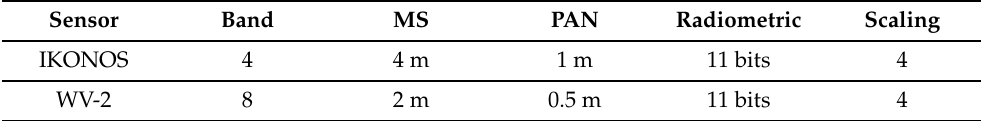
Table 1. Details of the Two Sensors Used in Our Experiments. Sensor Band MS PAN